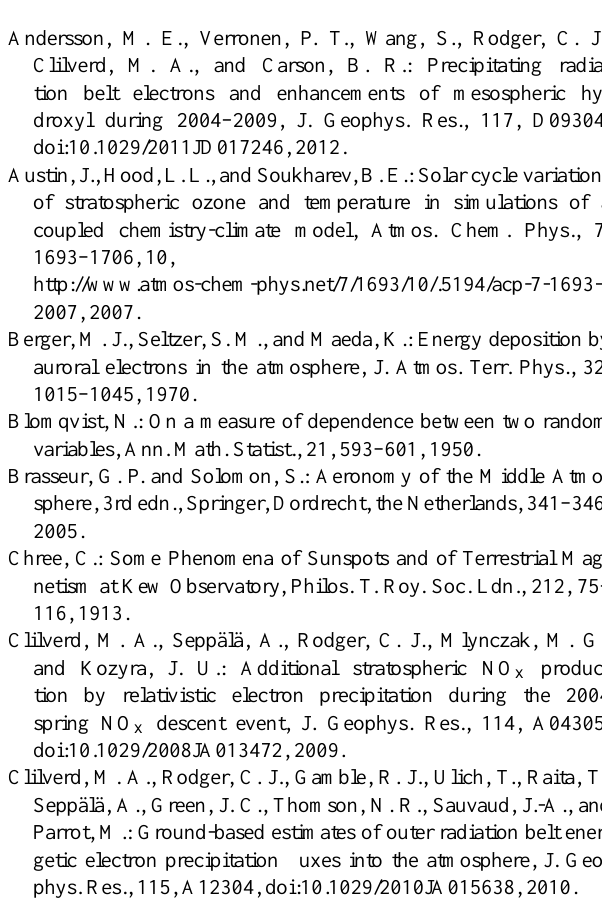
Fig. 9. Epoch type 1 SEA of ∆NO 2 at 65 ± 5 ◦ S geomagnetic latitude and 50km altitude. The blue error bars show the 1 σ range.